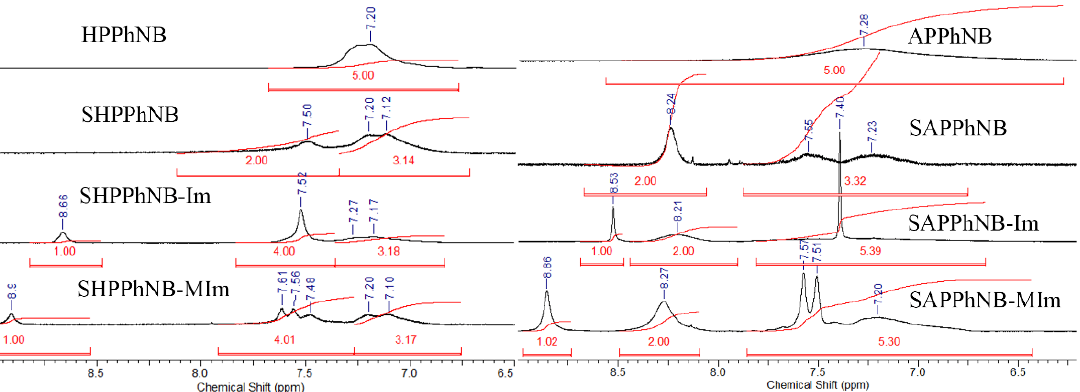
Figure 3. Aromatic region of 1 H NMR spectra of HPPhNB, SHPPhNB, SHPPhNB-Im, SNPPhNB-MIm (from top to bottom).